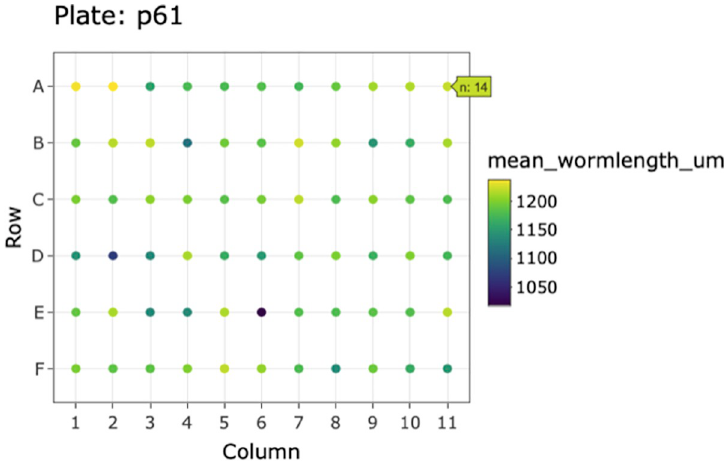
Fig 2. Example plot generated by viewPlate() . Well-wise plot of mean animal length ( μ m) from the summarized processed data. Interactive feature enables the assessment of the number of animals per well.